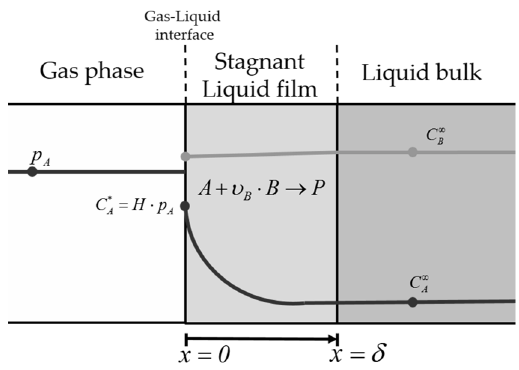
Figure 2. Concentration profiles of A and B within stagnant liquid film (Film Theory).